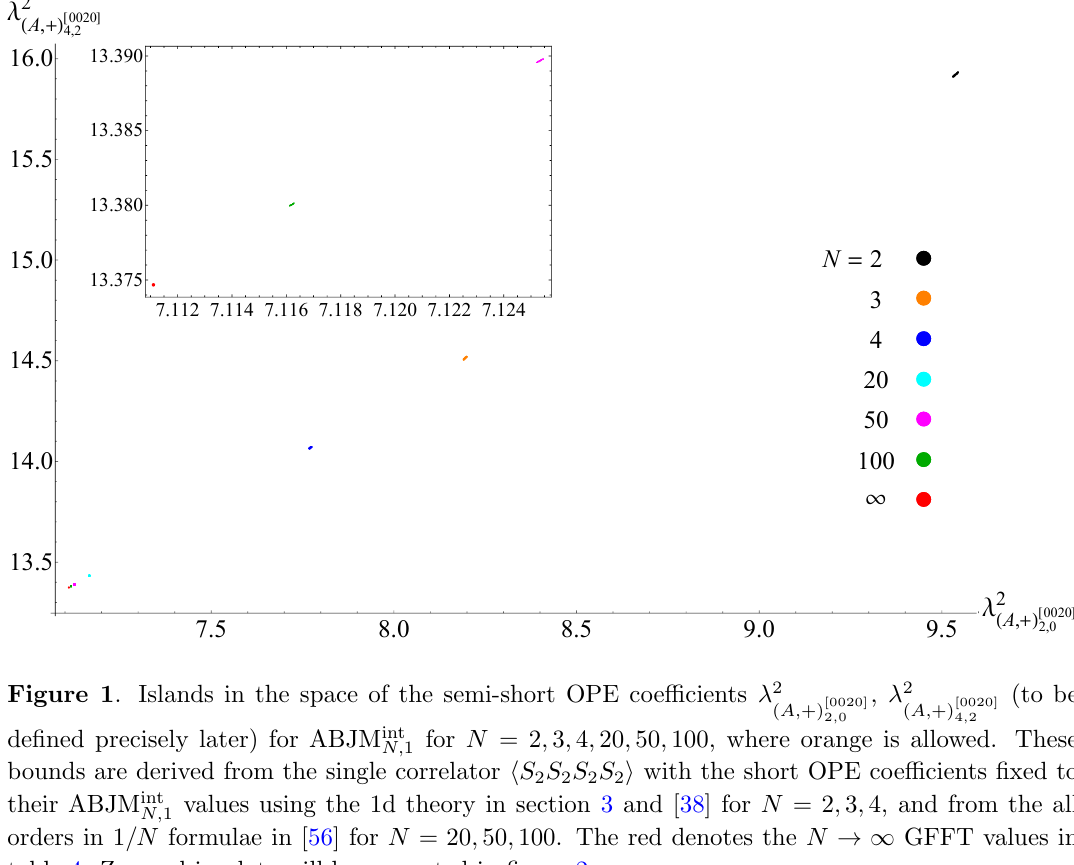
, (cid:21) 2 (to be ( A; +) [0020] 2 ; 0 ( A; +) [0020] 4 ; 2